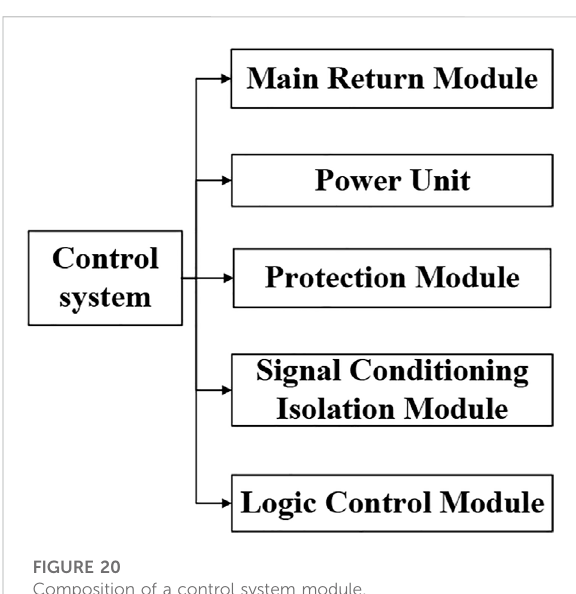
FIGURE 20 Composition of a control system